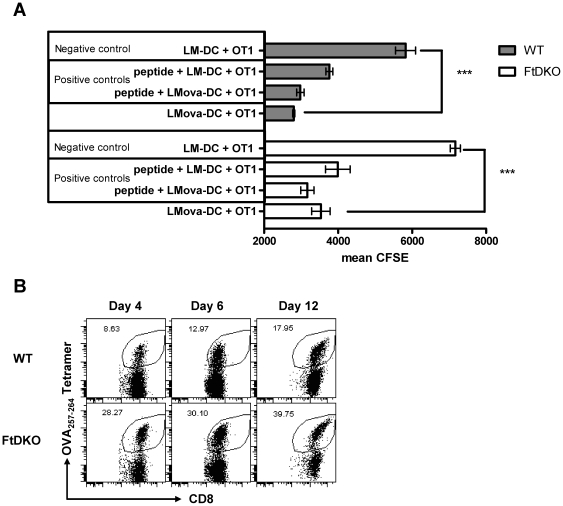
Antigen presentation and proliferation.Mean ± SD of triplicate cultures of CFSE reduction correlates to proliferation of OT.1 CD8+ T cells in response to DCs from LM or LM-OVA infected mice. Positive controls were pulsed with OVA257–264 peptide in vitro. Data are significantly different, ***(p<0.0001), relative to negative control (LM infected DCs) by two tailed t test with Welch's correction for unequal variance. Data are representative of 2 independent DC isolation experiments. (B) Representative flow cytometric profile indicating in-vitro antigen-dependent proliferation of OVA257–264-specific CD8+ T cells on different days of in vitro culture. Samples were obtained from in-vitro cultures in T-75 flasks. Data are representative of three such independent experiments conducted.